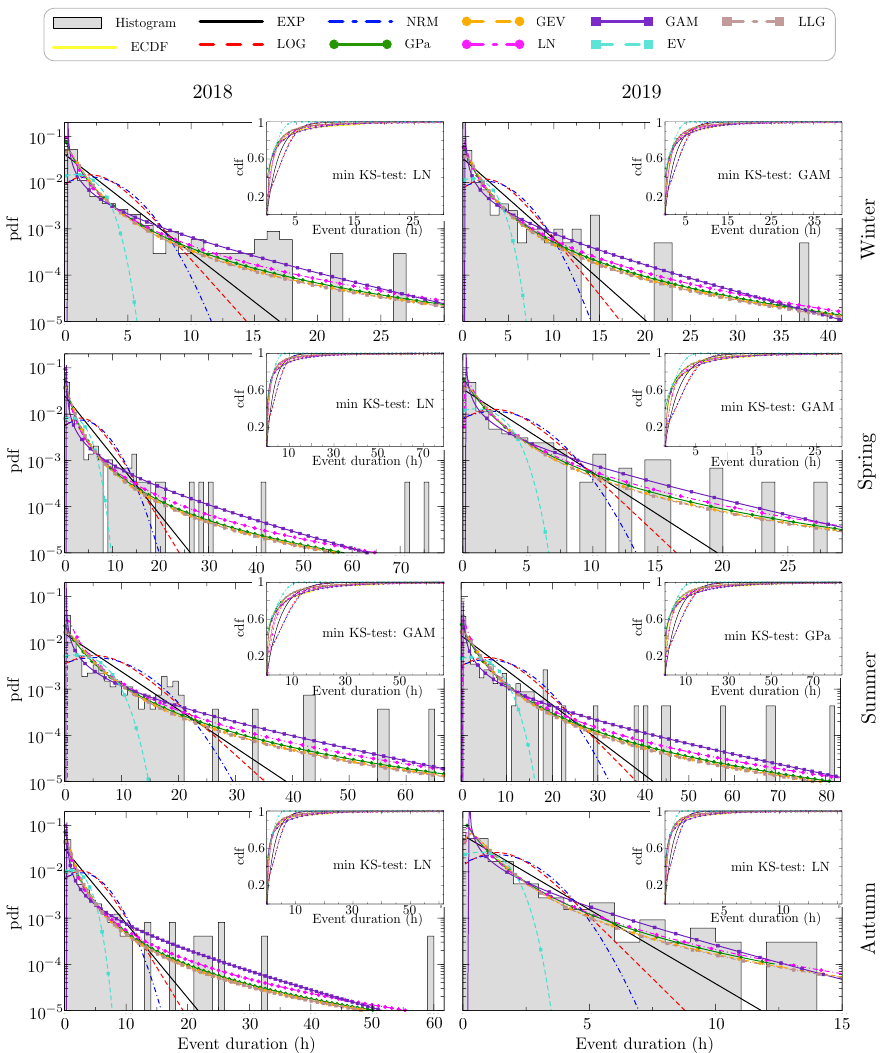
Figure 6. Probability density functions of fog events over time for L-moments approach fixing the threshold to 2000 m. The CDF is located in the insets. Each row corresponds to a season and each column to a